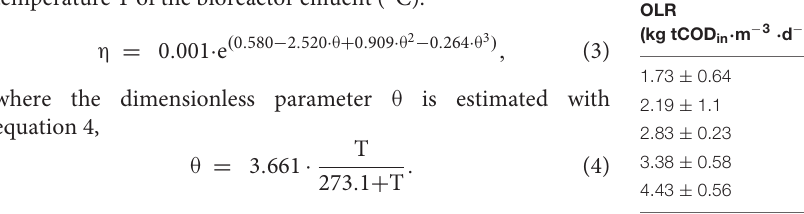
where J is the instantaneous flux (L · m − 2 · h − 1 ) measured at the temperature T of the bioreactor effluent ( ◦ C).